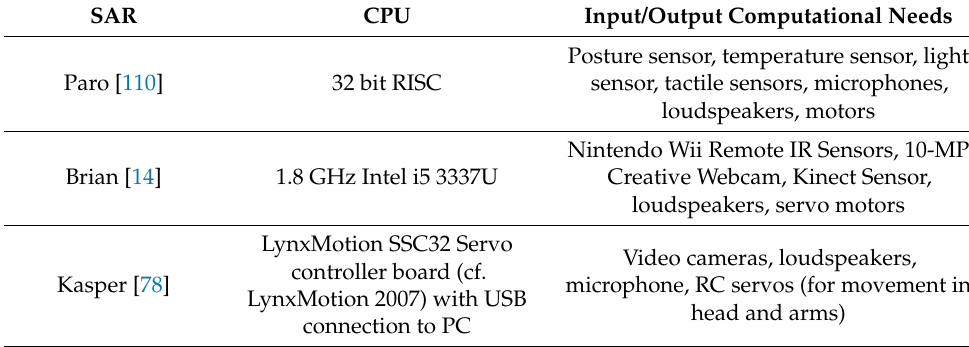
Table 3. Computational specifications of different existing